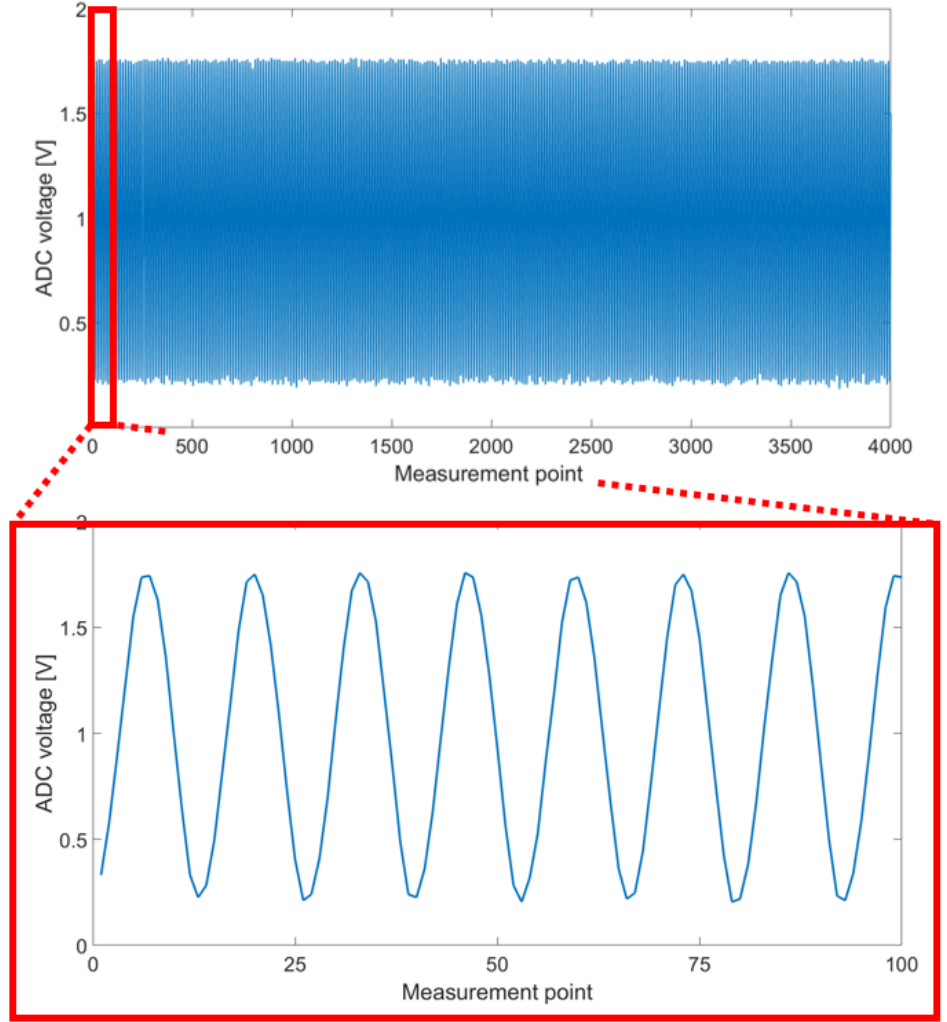
Figure 5. Measurement of a 100kHz, 3mV sine wave amplified and digitized by the sensor node, data plotted in